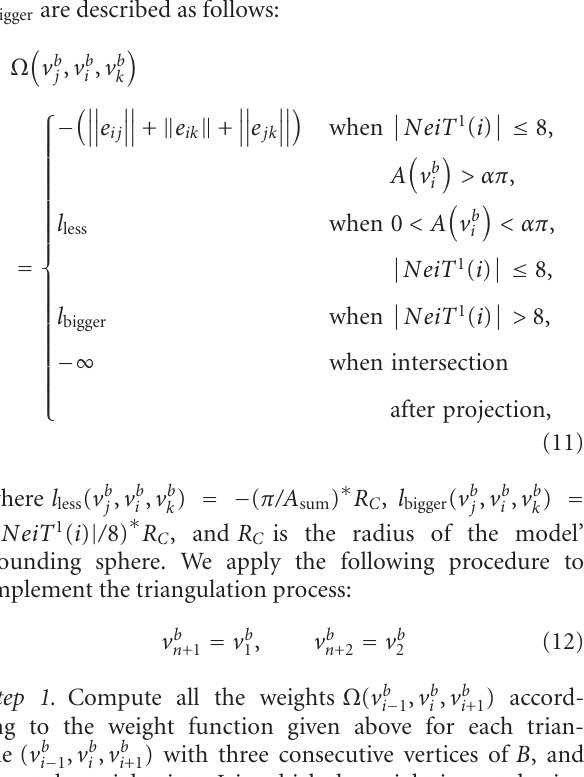
Figure 8: Abnormal results of the triangle being added when A ( v b close to π